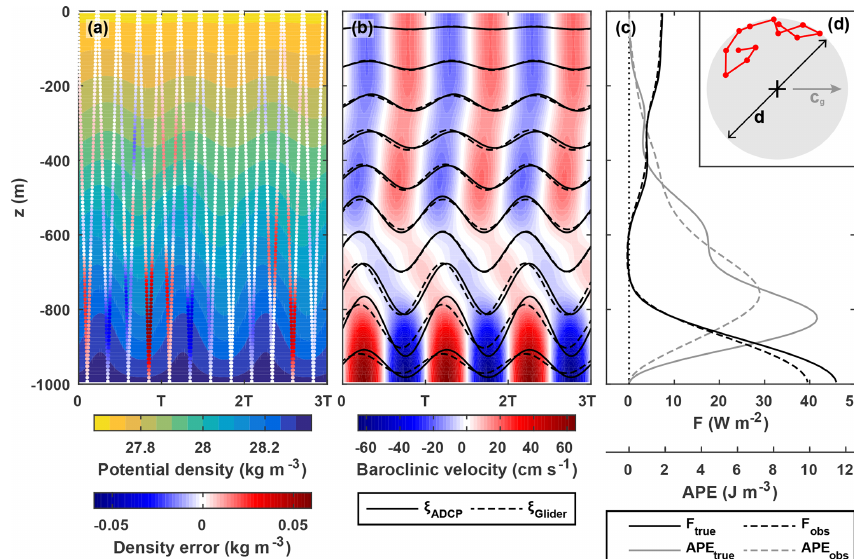
Figure 7. (a) Potential density for an idealized M 2 multi-mode internal tide overlaid with the error in measured density due to imperfect co-location of a glider and ADCP. The x axis is time in M 2 cycles. Positive error indicates an overestimation of density. (b) Baroclinic velocity (colour) for the same idealized internal tide overlaid with vertical isopycnal displacement at the ADCP ( ξ ADCP , solid black lines) and calculated from measured density ( ξ Glider , dashed black lines) every 100m. (c) “True” and “observed” internal tide energy flux (black) and available potential energy (grey). (d) Location of the pseudorandomly distributed glider path (red) relative to the ADCP (black cross). The diameter of the watch circle, d = λ/ 4, where λ = 80km is the mode-1 horizontal wavelength. c g is the direction of tide